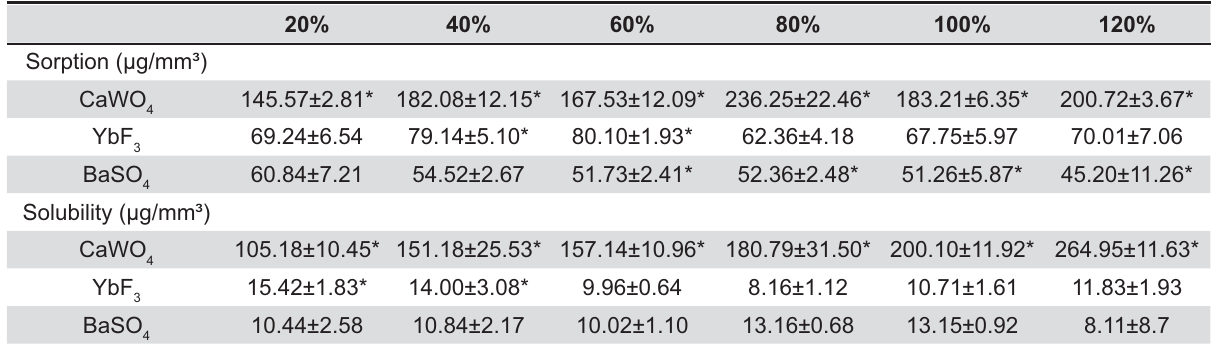
Table 3- Means±standard deviation for the water sorption and solubility of experimental sealers